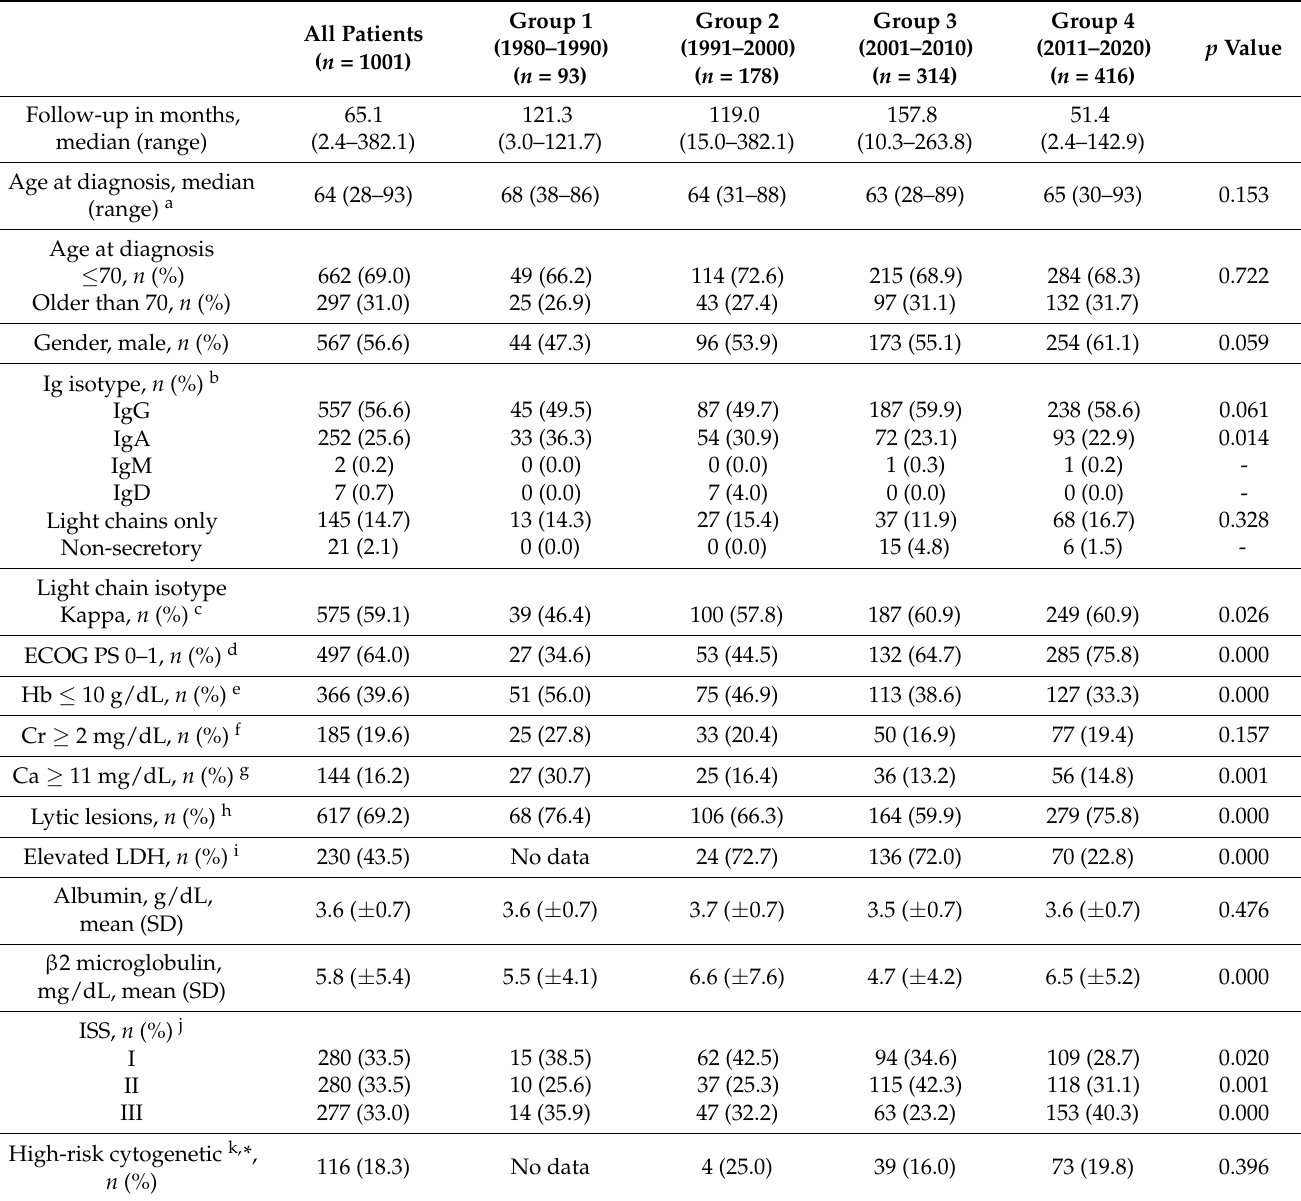
Table 1. Baseline characteristics of the entire